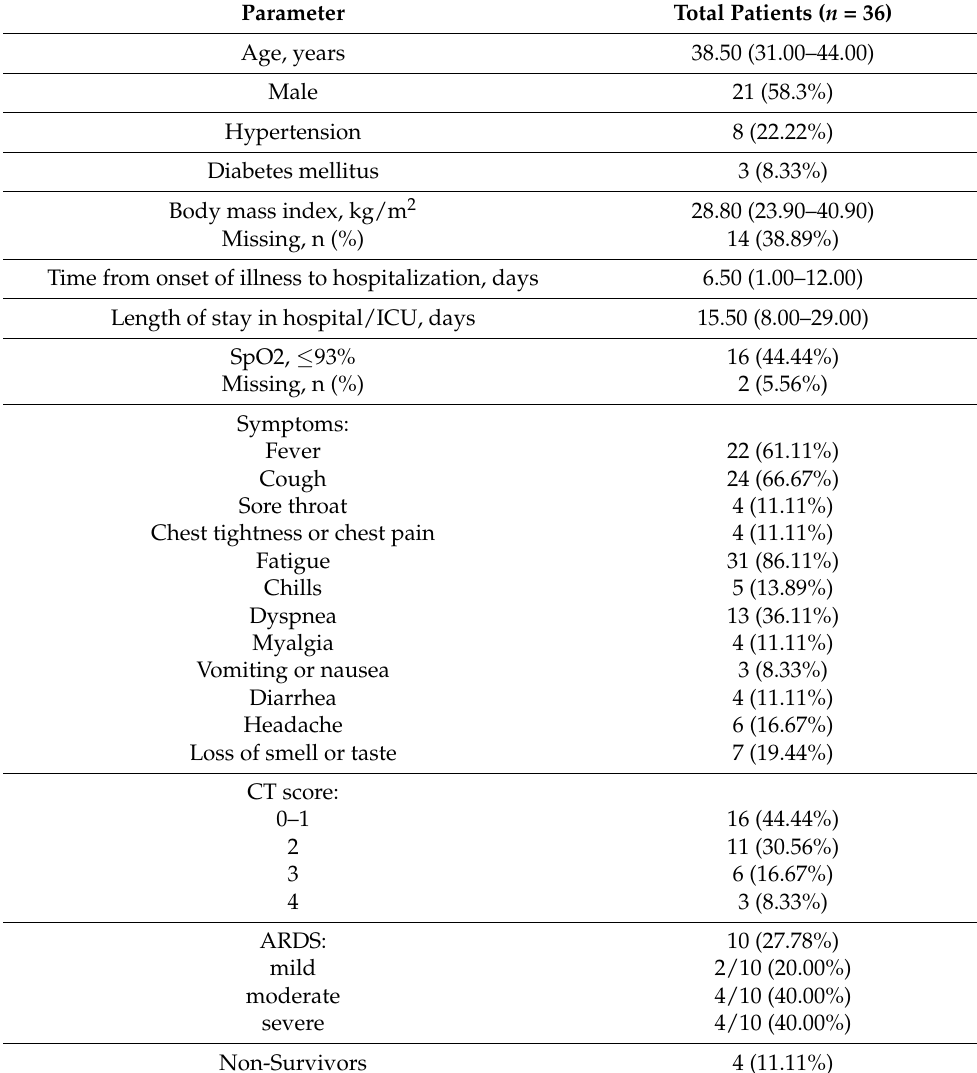
Table 1. Baseline characteristics of hospitalized patients with COVID-19.